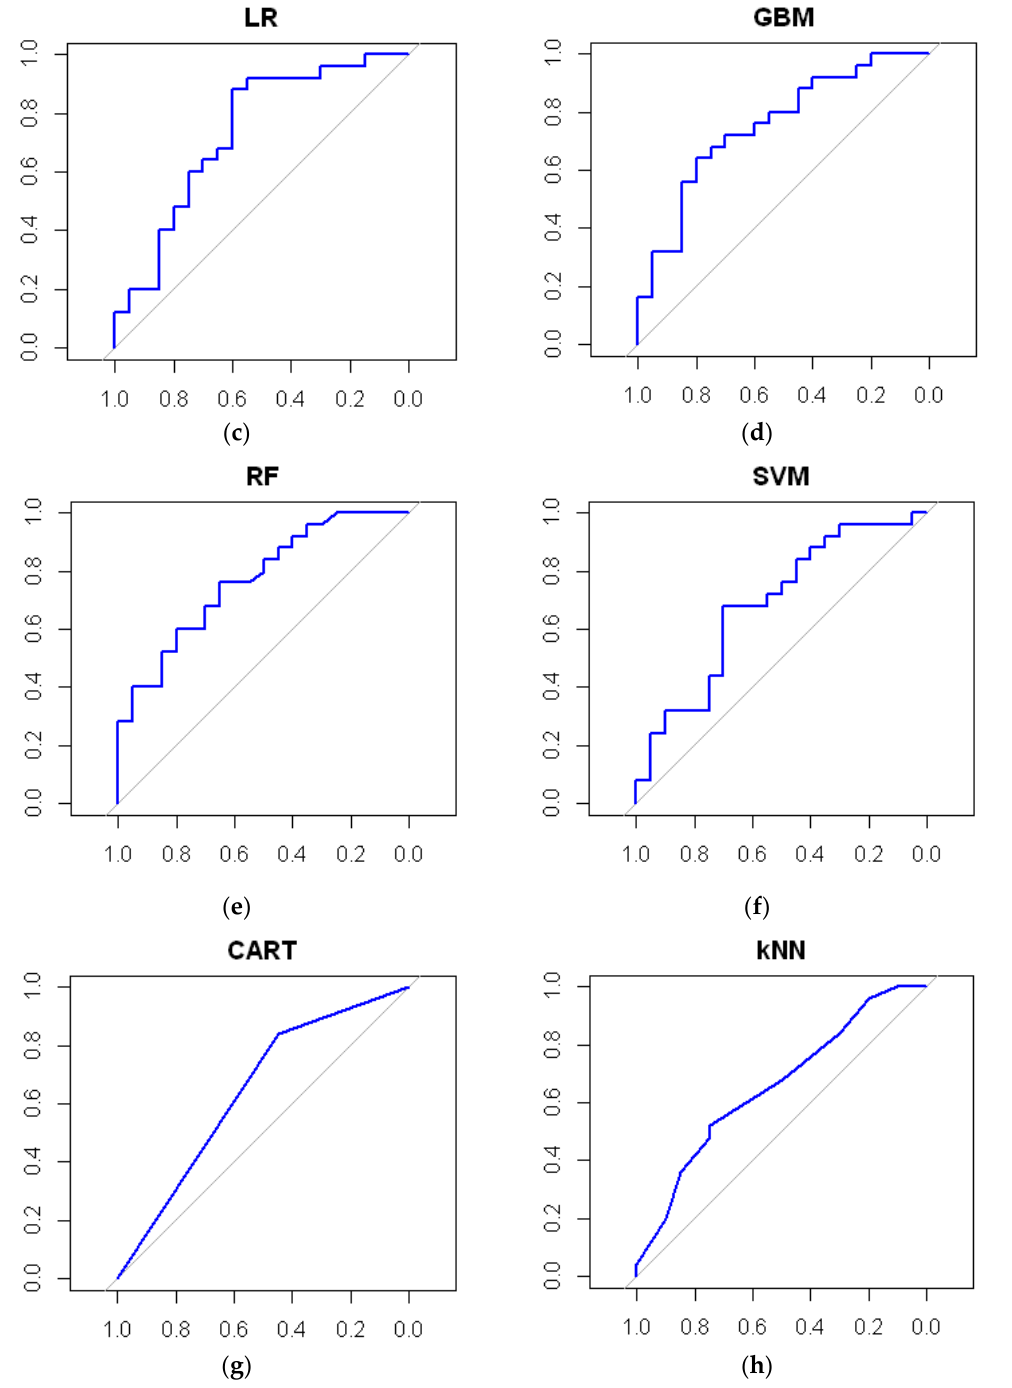
Figure 4. ROC curves for representing models.